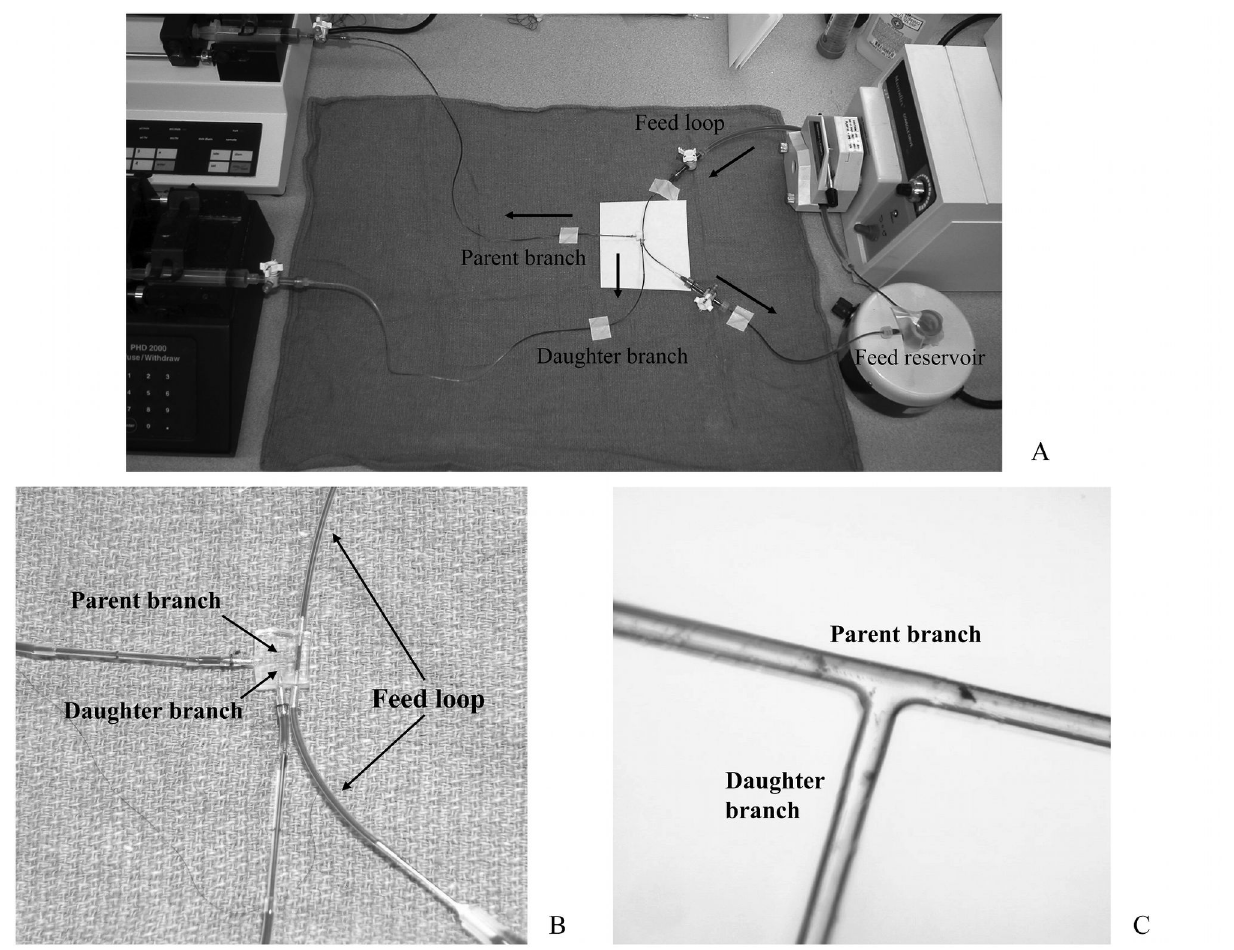
Figure 1. Microchannel bifurcation setup. A. Microchannel experimental set-up. The feed reservoir and loop are positioned on the right. Blood enters from the top and as it traverses through the feed channel, a fraction is aspirated into a 50 µm parent branch which passes straight through the plastic mold to the discharge port which is connected the top syringe pump. The parent branch gives rise to a 50 µm daughter branch which is connected to the syringe pump on the bottom. Black arrows indicate the direction of blood flow. B. A microscopic view (10x magnification) of 50 µm bifurcation showing smooth, continuous contours. C. Photo of microchannel showing feed loop, parent branch, and daughter